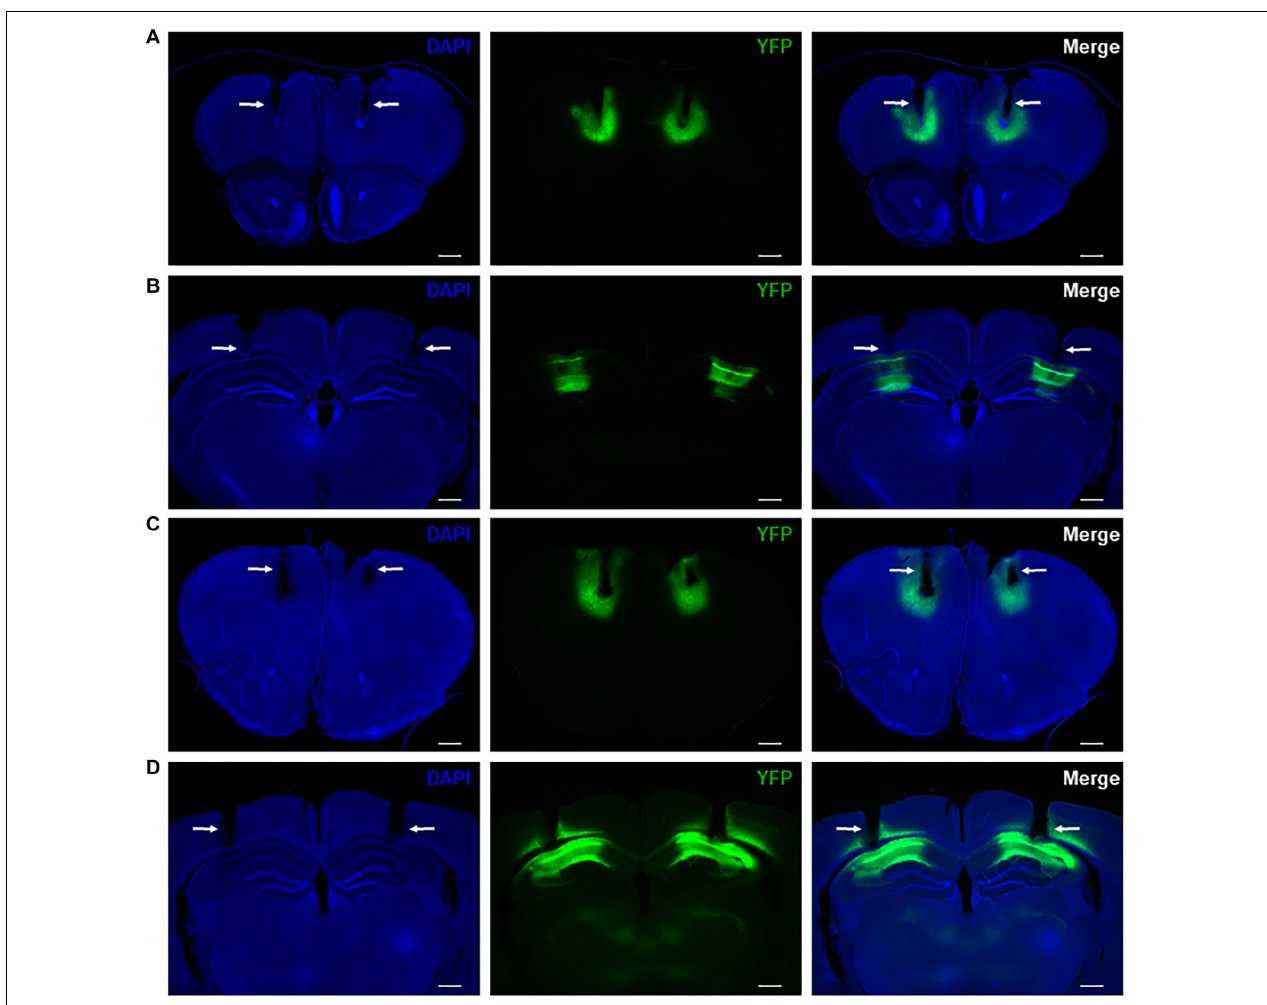
FIGURE 4 | Representative histology showing bilateral virus expression and electrode tracks in mice with AAV-YFP injection in the PFC (A) and HPC (B) as well as mice with AAV-YFP-difopein injection in the PFC (C) and HPC (D) . Electrode tracks are indicated by white arrows. Virus expression is limited to a small region around the injection sites and is colocalized with recording sites. Scale bar = 500 µ